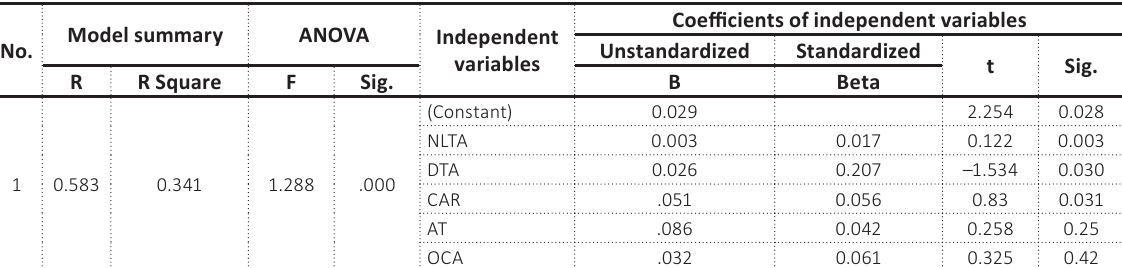
Table 4. Multiple regression test for working capital management